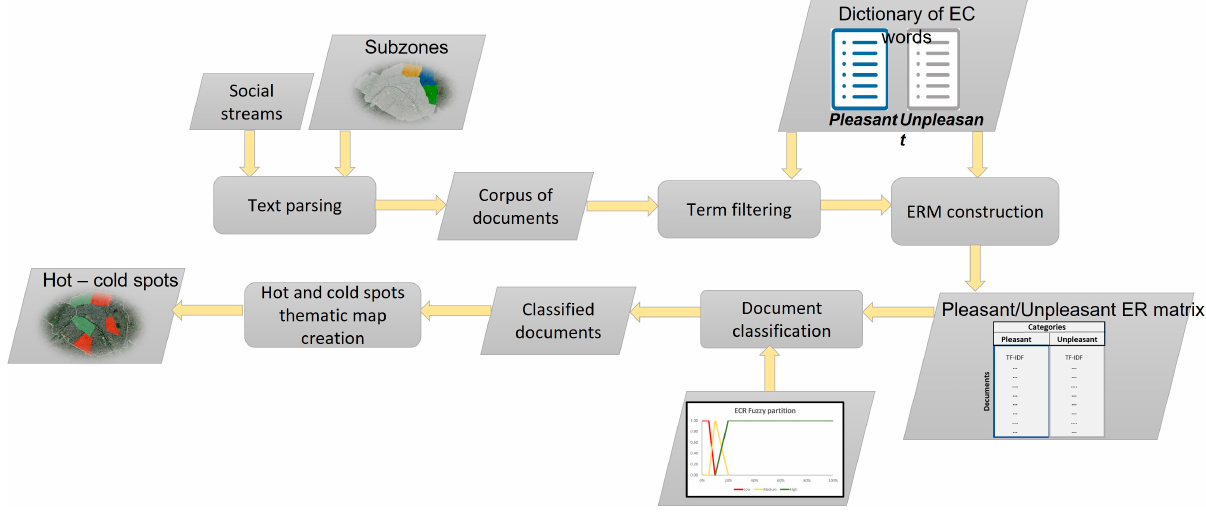
Figure 4. FESC: logical overview.